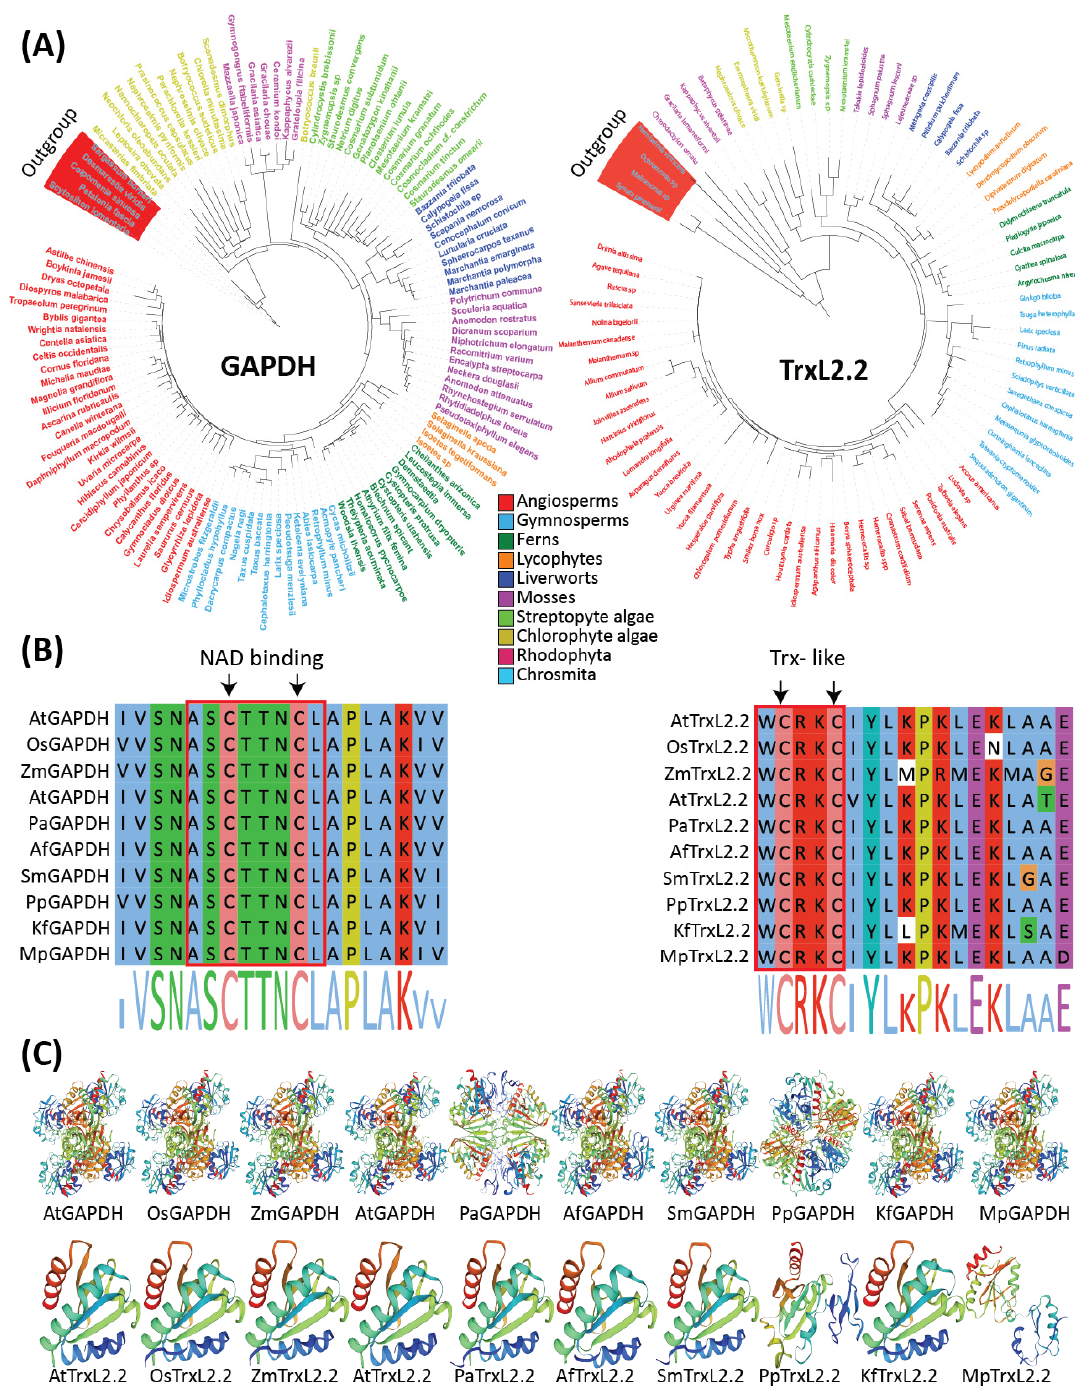
Figure 3. Phylogenetic, conserved domains and 3D protein analysis of GAPDH and TxL2.2 in Plants and algae ( A ) Phylogenetic tree of GAPDH and TrxL2.2 from representative plant and algae lineages. The alignment was performed using MAFFT v7.409 [86]. A maximum likelihood tree was generated using RAxML-HPC2 on XSEDE. ( B ) Sequence alignment of GAPDH and TrxL2.2 for conserved NAD binding and Trx-like domains, respectively. The alignment was performed using Jalview [87] with default parameters. ( C ) 3D protein structures were predicted using a Swiss-prot server in representative algae and plant species. At, Arabidopsis thaliana , Os , Oryza sative; Zm , Zea mays; Amt , Amborella trichopoda; Pa , Picea abies; Af , Azolla filiculoids; Sm , Selaginella moellendorffii; Pp , Physcomitrella patens; Kf , Klebsormidium flaccidum; Mp , Marchantia polymorpha